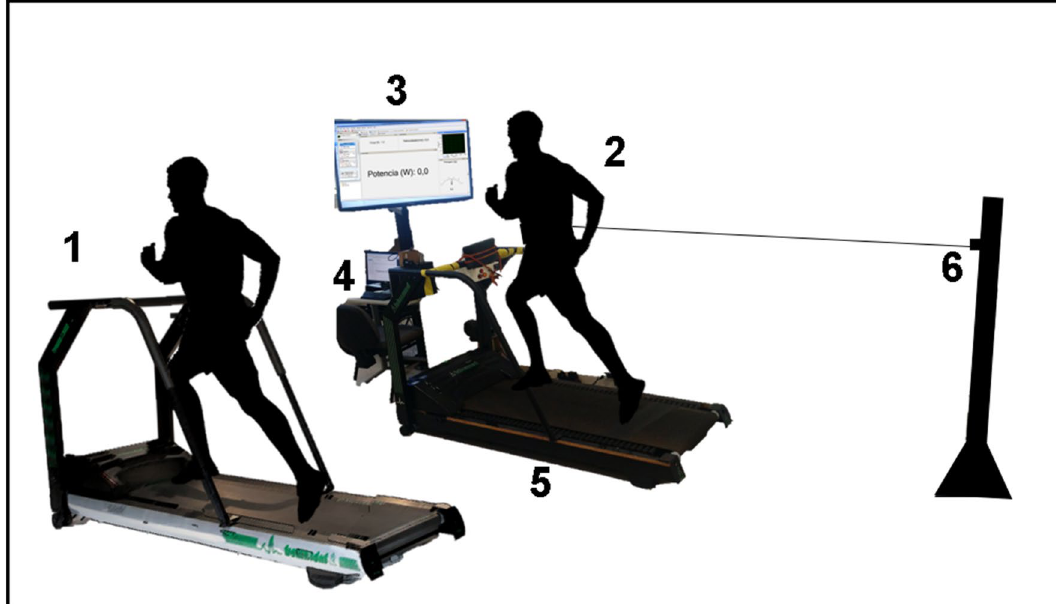
Figure 1. Set-up image for the studied ergometers. (1) conventional MT running; (2) tethered NMT running; (3) monitor for visual feedback of horizontal plane power performance; (4) computer and signal acquisition equipment; (5) instrumented NMT for vertical force measurement; (6) load cell attached to a fixed metal pole enabling heigh adjustment to measure force in the horizontal plane. In both cases, the runners were equipped with a portable gas analysis device at all times.